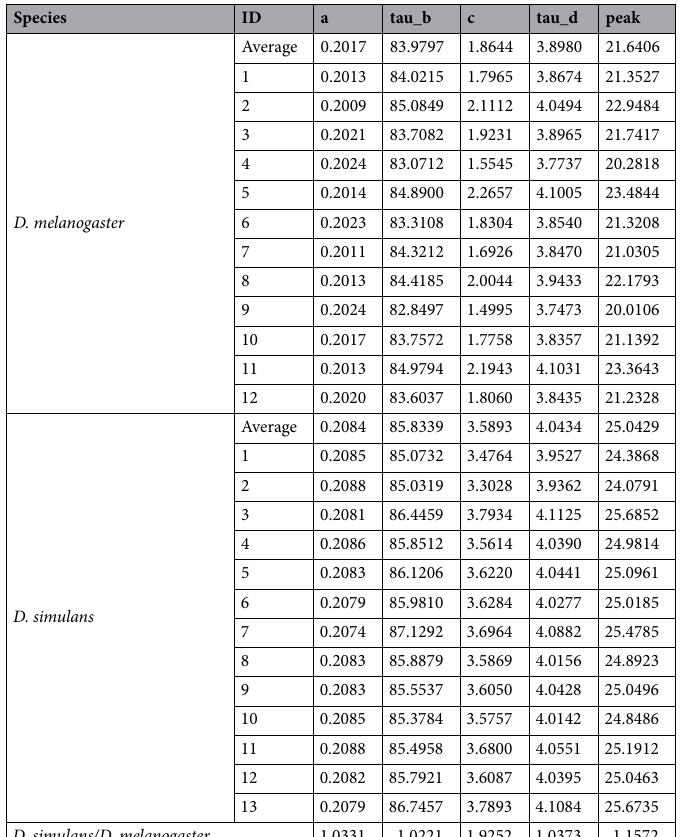
Table 1. Parameters of fit function. Parameters of the average and each individual estimated by MCMC are shown. Calcium imaging datasets of D. melanogaster (N = 12) and D. simulans (N = 13) were used. An ID was assigned to each individual dataset. The ratios of average parameters between species are shown at the bottom ( D. simulans / D. melanogaster